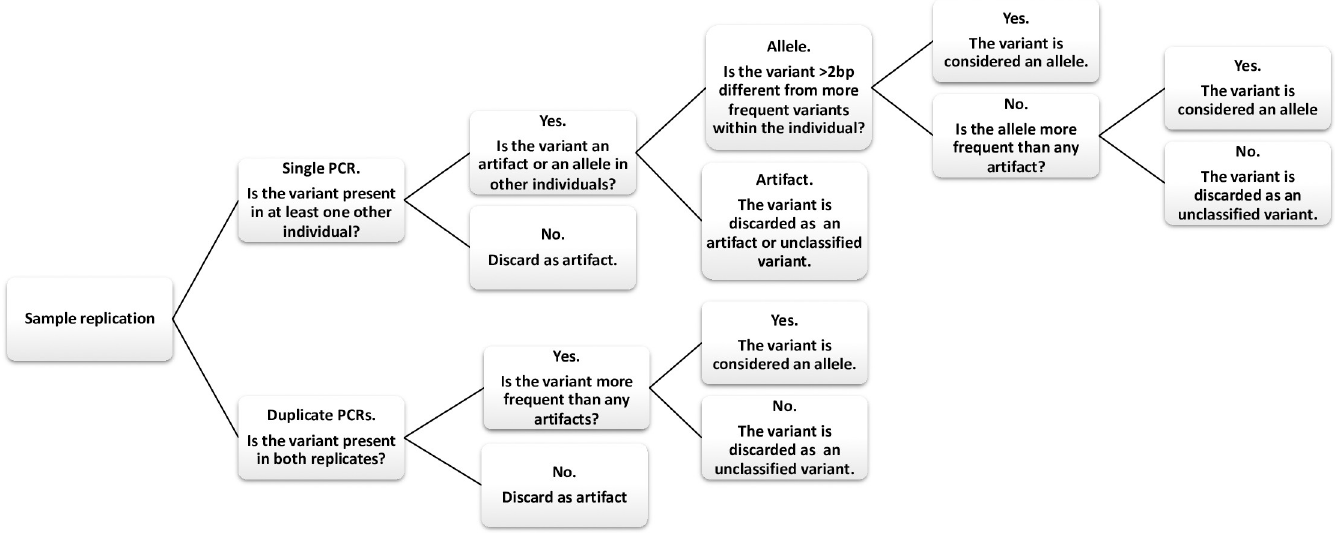
Fig 2. Genotyping decision tree. Sequence of steps used for distinguishing putative alleles from putative artifacts.